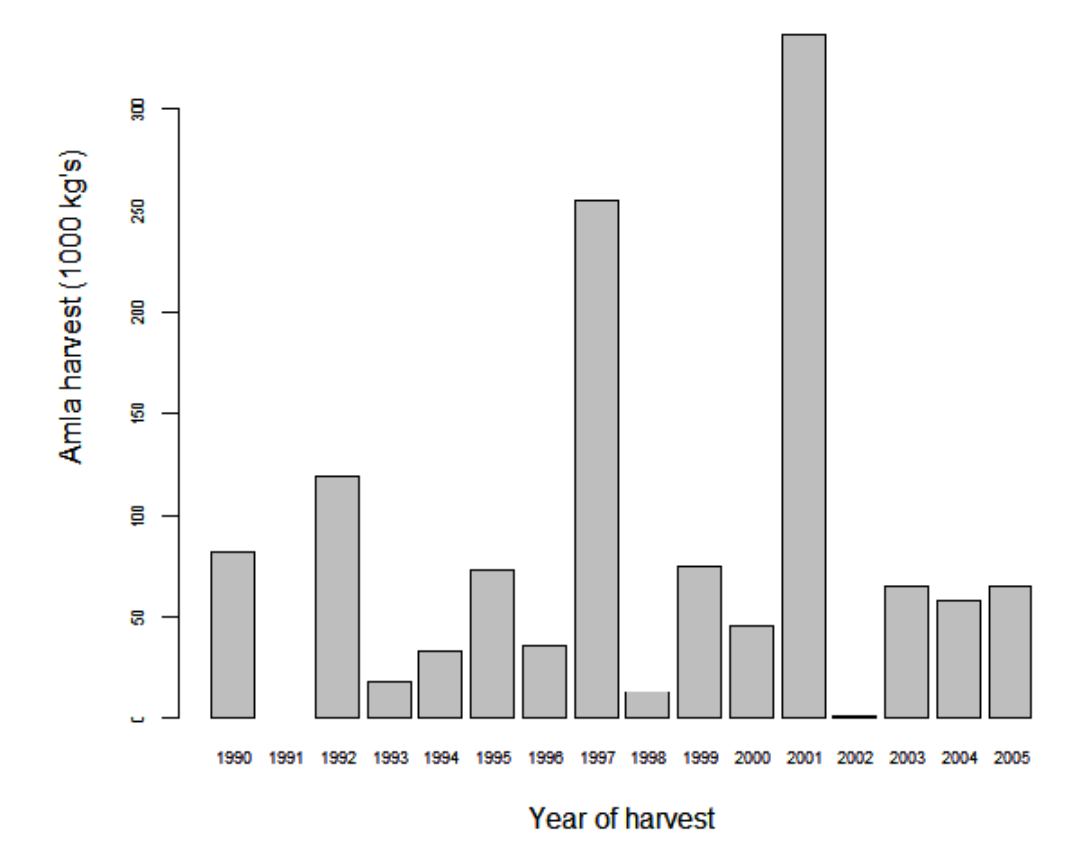
Fig. 3. Total amla harvest between 1990 and 2005. Data for the Biligiri Rangaswamy Temple Wildlife Sanctuary for 1990–2005, provided by the Large-scale Adivasi Multipurpose Society of Chamarajanagar, Karnataka,